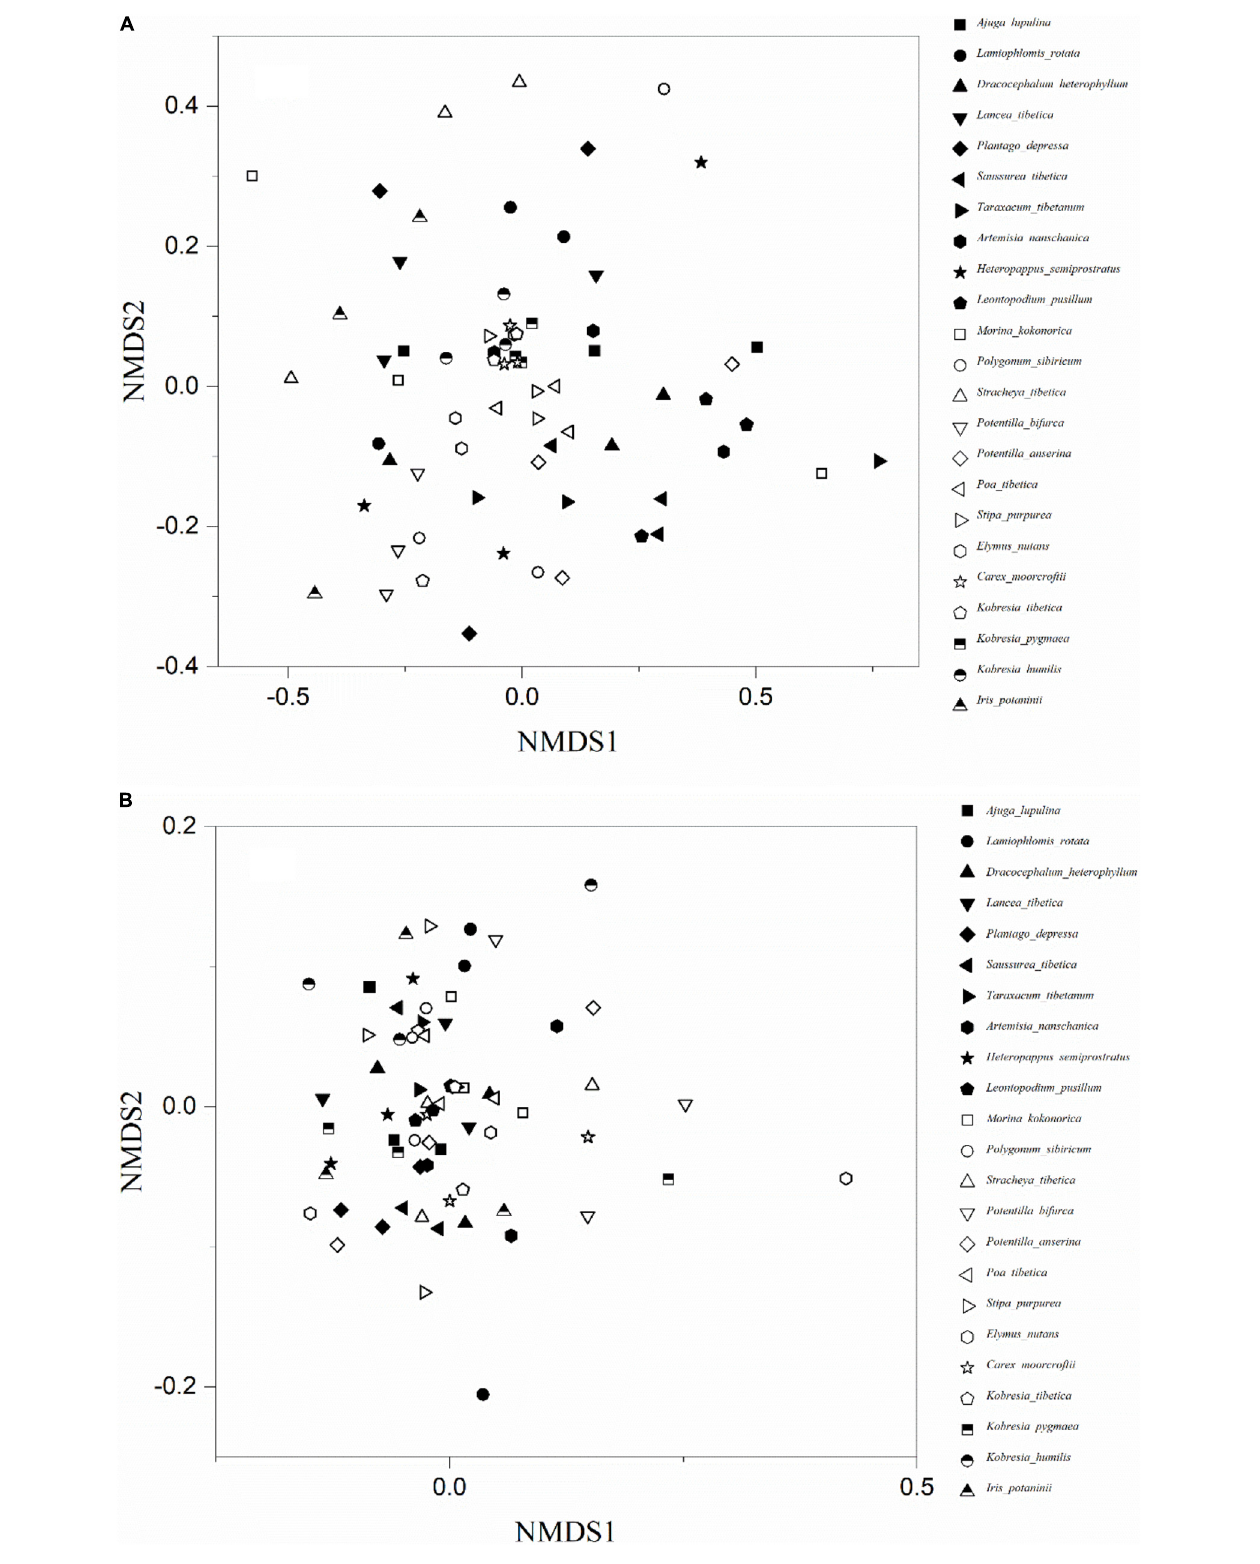
FIGURE 4 | The non-metric multidimensional scaling (NMDS) ordinations of AMF taxonomic (A) and phylogenetic (B) community composition of 23 plant roots.